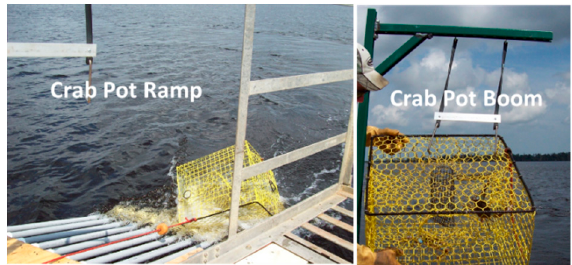
Figure 5. Innovations to mitigate musculoskeletal risk in crab harvesting when lifting pots with a ramp and boom. Courtesy of Gary A. Mirka, Iowa State University.